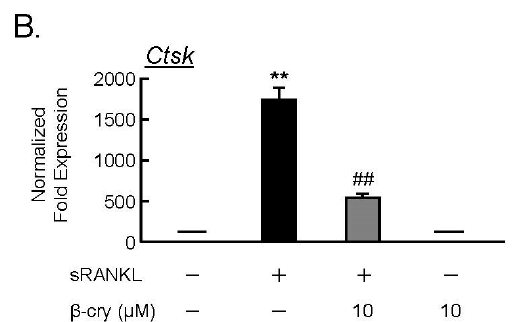
Figure 4. β -cry inhibits the soluble RANK ligand (sRANKL)-induced osteoclast differentiation and expression of cathepsin K (Ctsk) mRNA in RAW264.7 cells. RAW264.7 cells, which are mouse macrophages, were cultured with sRANKL (100 ng/mL) and β -cryptoxanthin (5–10 µ M) for four days. ( A ) Osteoclasts were stained for tartrate-resistant acid phosphatase (TRAP), and the percentage of TRAP-positive multinucleated cells was measured. Data are expressed as the mean ± SD for eight independent wells. Arrowheads indicate TRAP-positive multinucleated osteoclasts. Bar = 500 µ m. ( B ) Total RNA was extracted and reverse transcribed into cDNA. cDNA was amplified, and the mRNA expression of cathepsin K (Ctsk) was measured by RT-qPCR. Data are expressed as the mean ± SD of three replicated wells in triplicate. Significant differences are indicated, ** p < 0.01 vs. control; ## p < 0.01 vs. sRANKL.